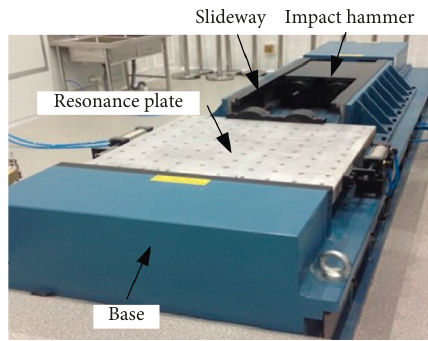
Figure 8: Shock spectrum response test device.